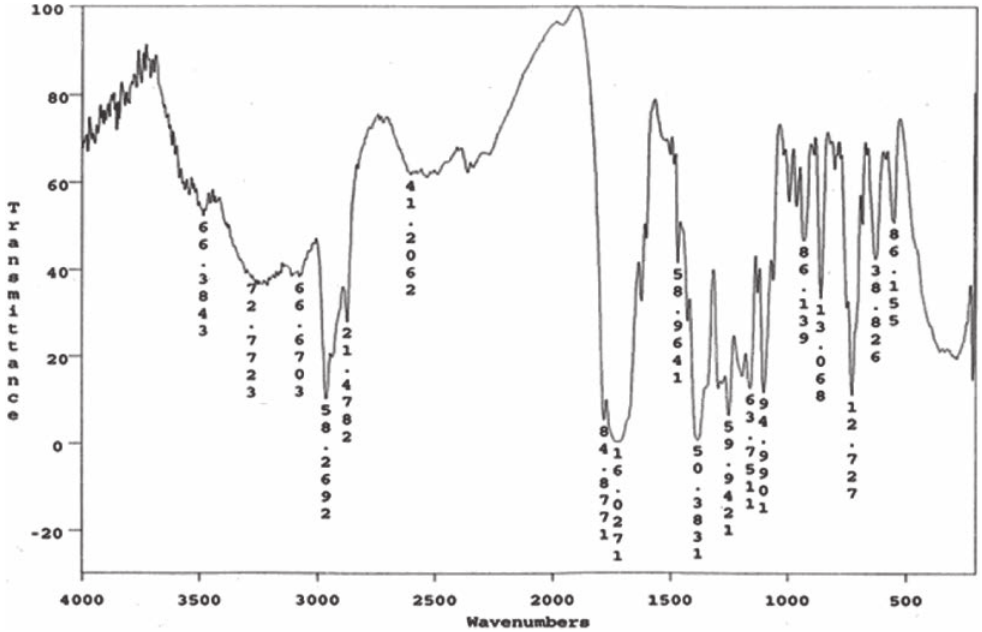
Fig. 2: FTIR spectrum of diimide-diacid 7a .